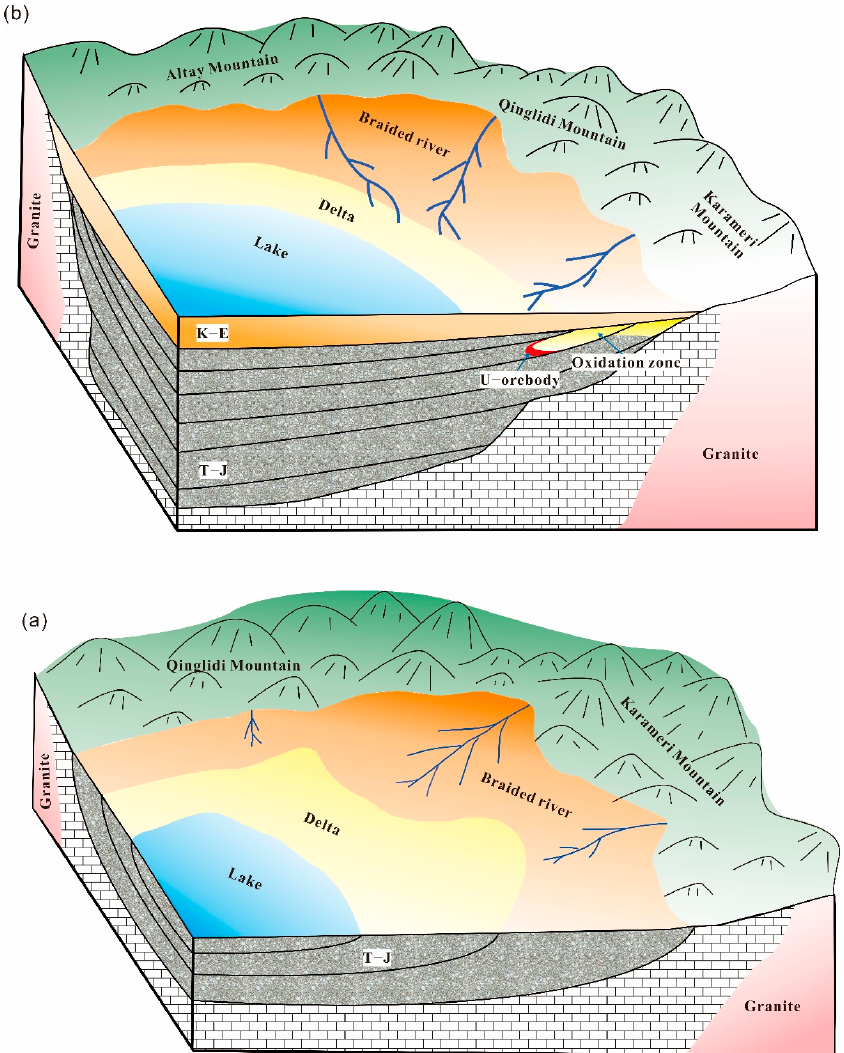
Figure 11. Model of influence of tectonic uplift and provenance switch on sandstone-type uranium mineralization. ( a ) Uranium-rich strata were formed under tectonic setting of slow uplift during Triassic and Jurassic, and Qinglidi and Karameri Mountains were dominant provenance areas. ( b ) Interlayer oxidation and uranium ore body occurred after the Cretaceous rapid uplift, and Altay Mountain was proved to be one of the dominant provenance areas. T − J: Triassic and Jurassic. K − E: Cretaceous and Paleogene. The rapid uplift event in the Cretaceous caused the regional unconformity between the Cretaceous and Jurassic strata. Affected by this event, the basin–mountain height